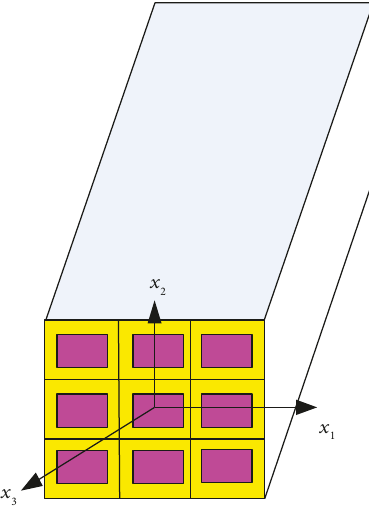
Figure 7: Fiber arrangement of nonlinear matrix ferroelectric